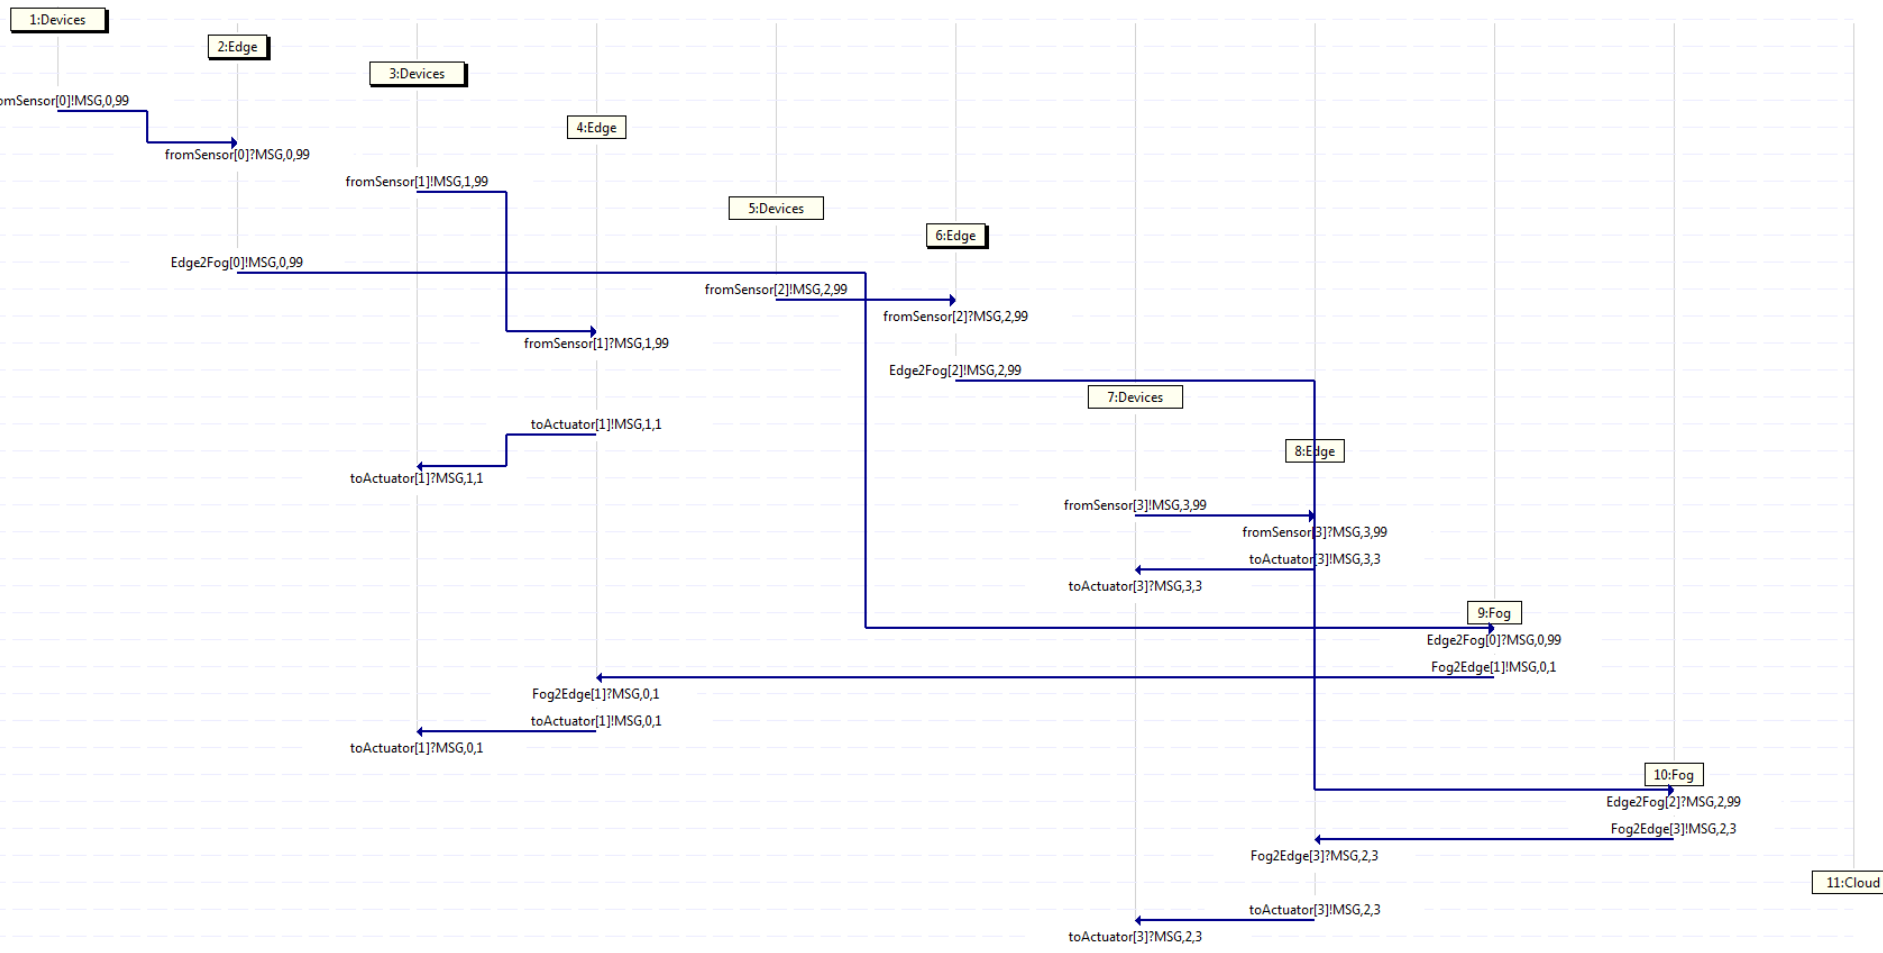
Figure 7. Capture where only edge servers and fog servers deal with all